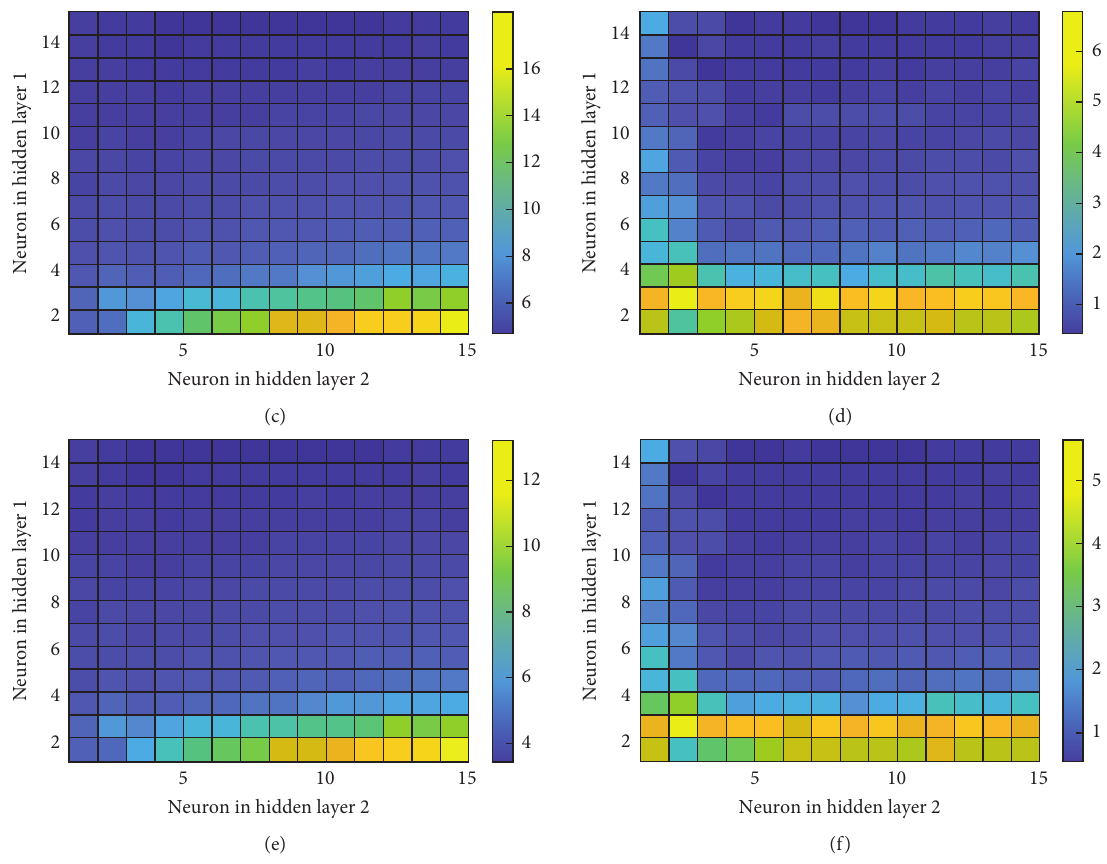
Figure 6: Color-map of ANN with 2 hidden layers in the function of the neuron of hidden layer for the training part with respect to (a) mean values of R 2 ; (b) StD of R 2 ; (c) mean of RMSE; (d) StD of RMSE; (e) mean of MAE; and (f) StD of